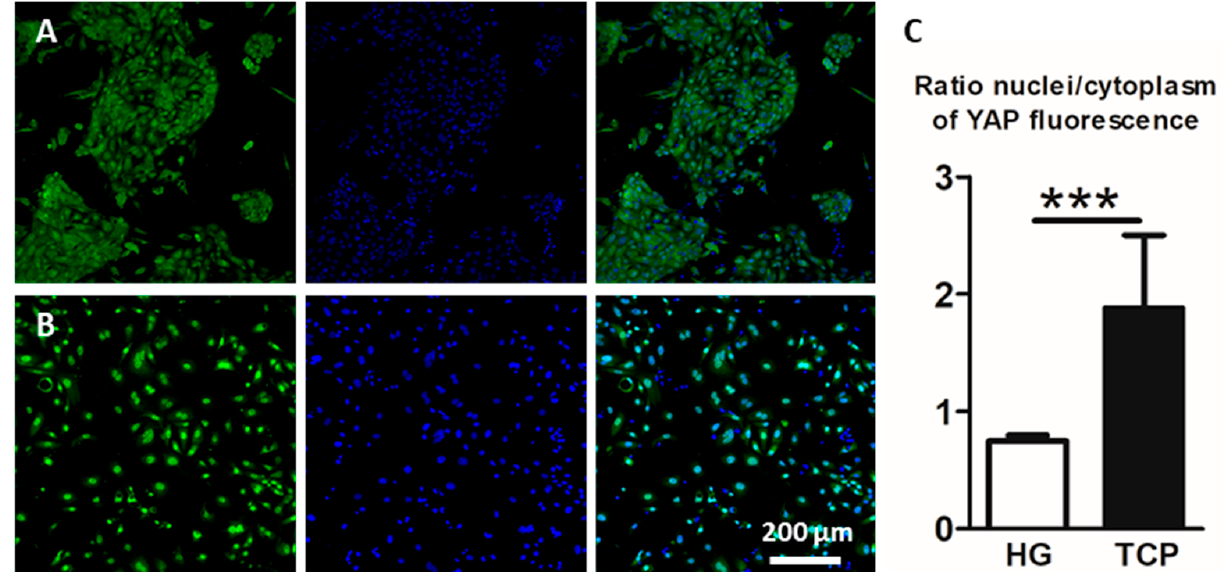
Figure 4. Alveolar type II cells were cultured on hydrogel ( A ) or on a plate ( B ) and stained for YAP protein (green). YAP nuclear and cytoplasmic expressions were quantified and expressed as the nuclei/cytoplasm fluorescence ratio in both conditions hydrogel (HG) and tissue culture plate (TCP) ( C ), *** p < 0.001.